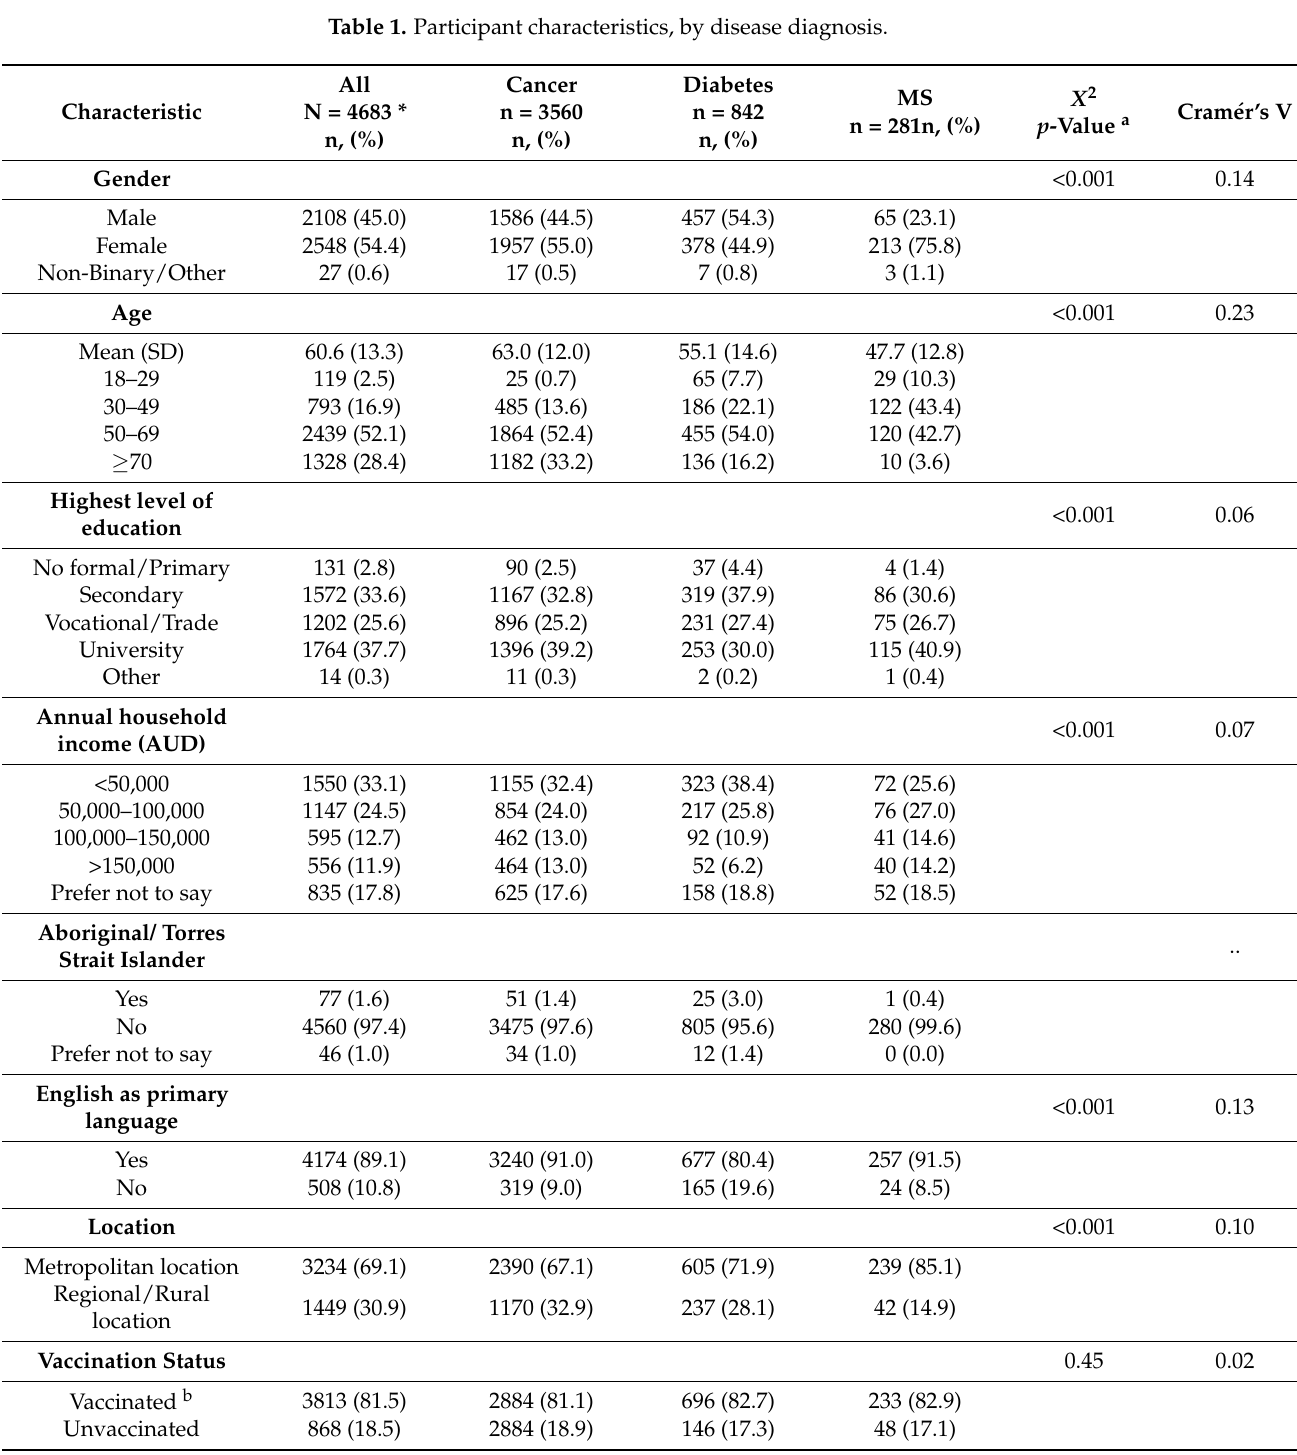
Table 1. Participant characteristics, by disease